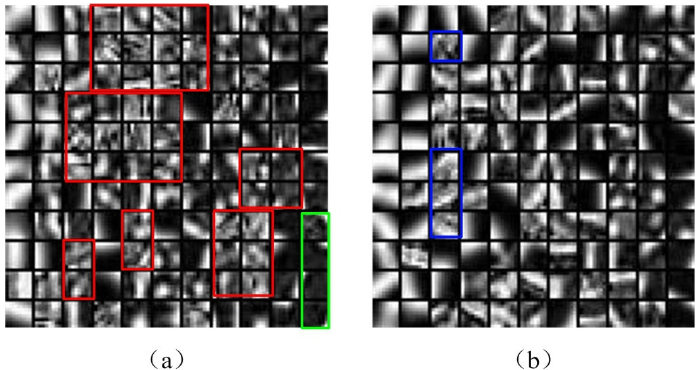
Figure 4. Details Comparison of Learned Dictionary, ( a ) shows the details of a learned dictionary using traditional method; and ( b ) shows the details of a learned dictionary using proposed